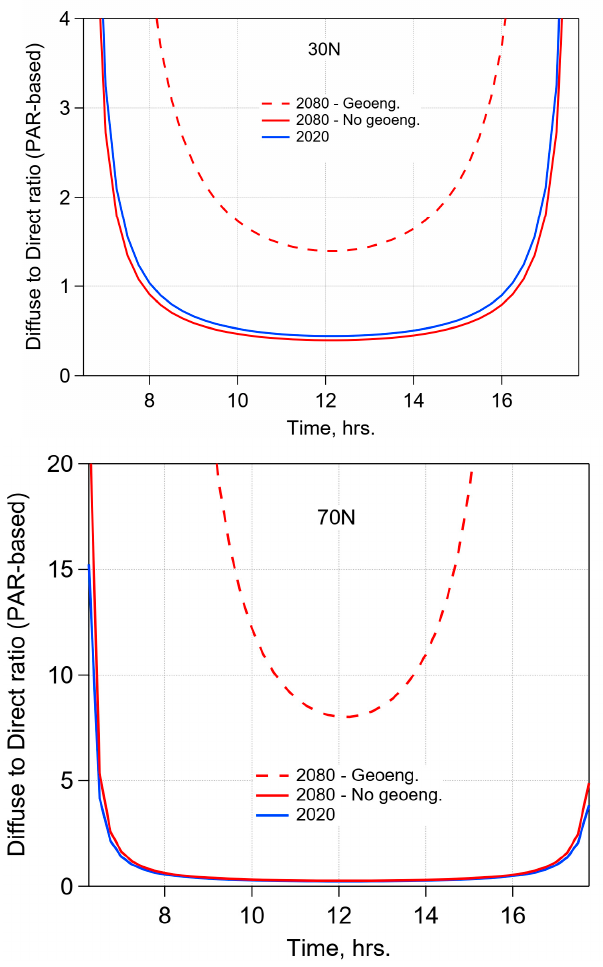
Figure 5. Ratio of diffuse sky radiation to direct solar beam at the surface, for the current atmosphere (March 2020, blue curve) and scenarios for March 2080 without geoengineering (red, solid) and with geoengineering by sulfur injection (red, dash). Based on photosynthetically available radiation (PAR) between 400 and 700 nm.